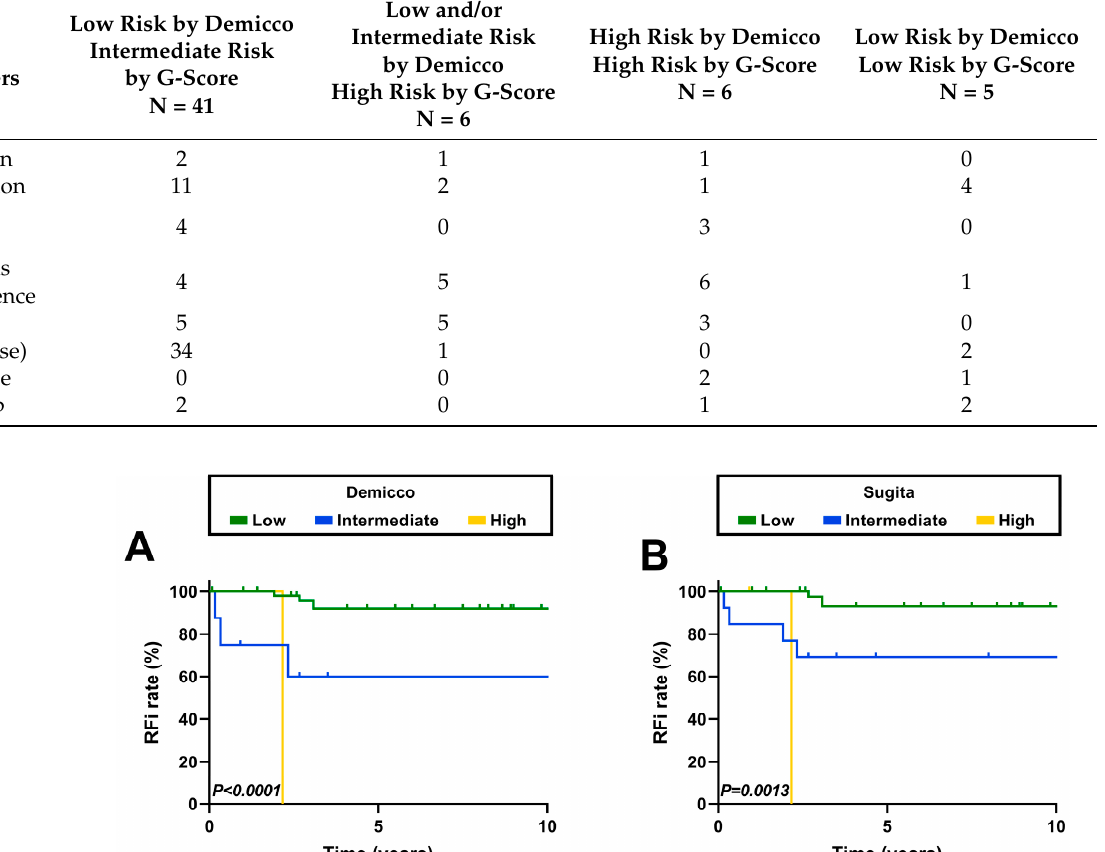
Table 2. Correlation between Demicco et al., and G-Score RSS for recurrence/metastasis, molecular alterations and outcome for all cases, showing both disagreement and agreement in assigned risk.